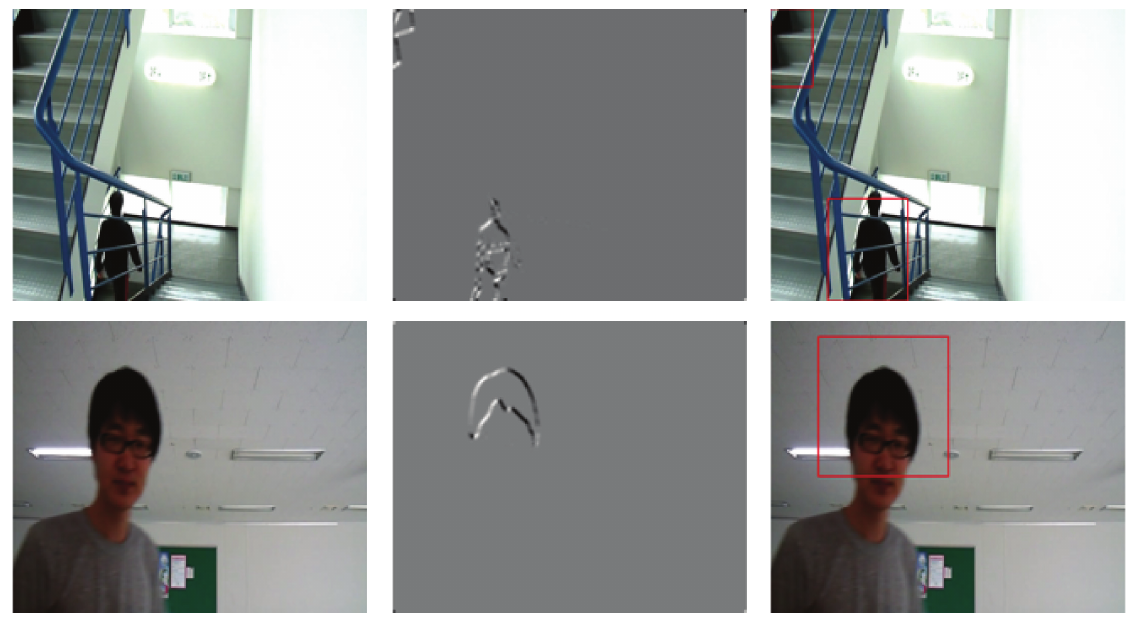
Figure 13: Videos (1) and (2): results using gradient saliency by utilizing Sobel